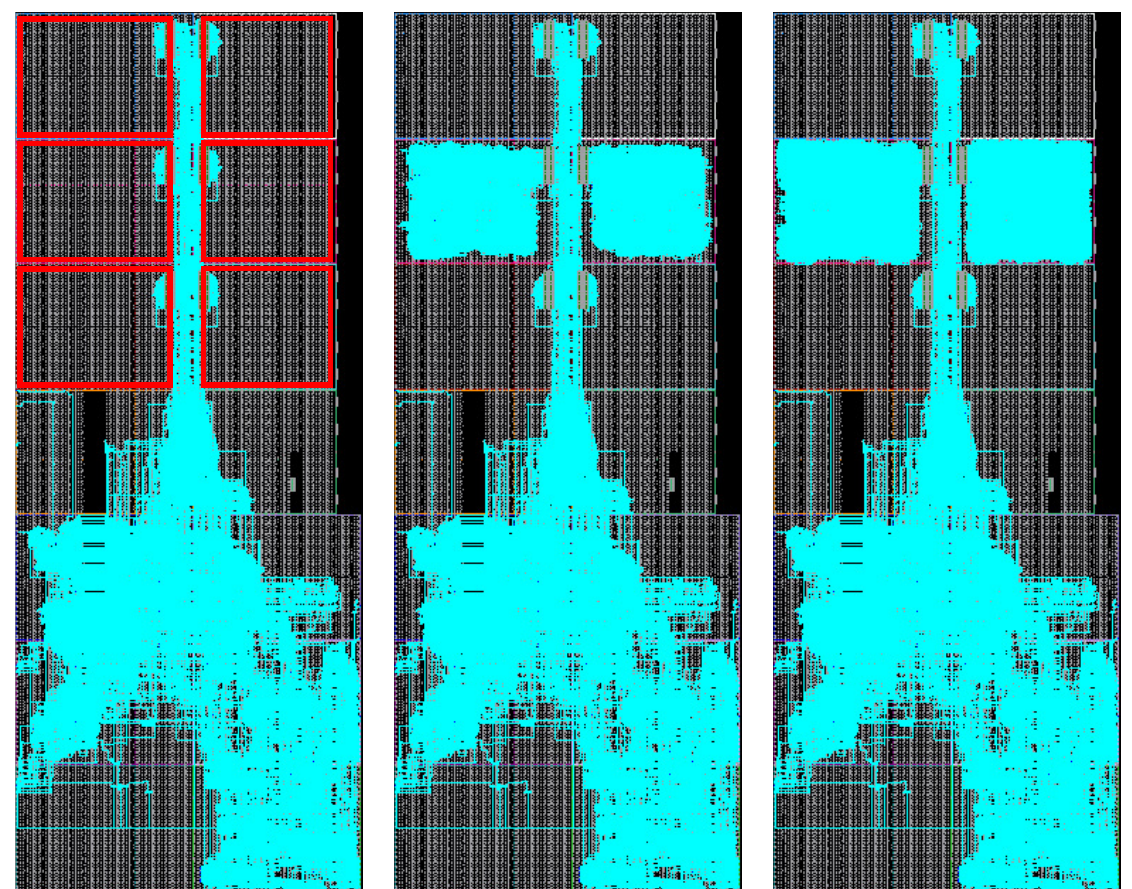
Figure 10. FPGA floorplanning of an ARTICo 3 -based system in the KC705 development